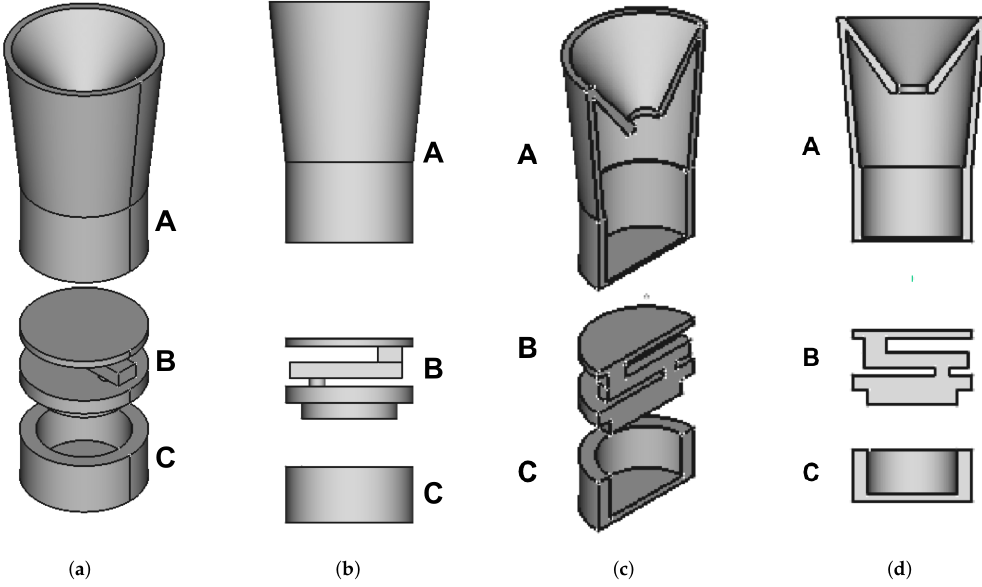
Figure 3. 3D model of the sensing structure: ( a ) axonometric view, ( b ) lateral view, ( c ) axonometric section and ( d ) lateral section. The basket used to collect the sand (A) has a flared shape in order to limit contacts with the inner walls of the rotating section that could alter the measured weight; the upper surface is shaped has a funnel. The load cell (B) is bolted to the closing cap of the amplifier housing and it is glued to an upper plate used to hold on the basket. The amplifier housing (C) contains the circuitry and it is closed in order to avoid sand infiltration